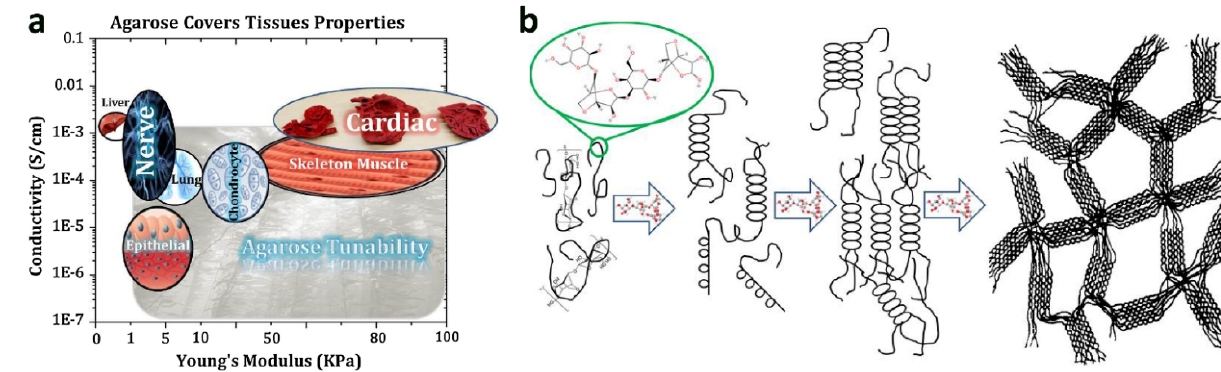
Figure 4. Agarose-based scaffold: ( a ) Adjustable features of agarose can result in flexible characteristics, ( b ) the molecular structure of agarose and schematic of its gelling process [67]. Table 1. Natural derived polysaccharides hydrogels and their combination with proteins in CTE.